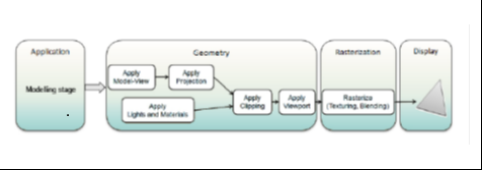
Figure 6: Rendering Pipeline after (Zechner and Green,